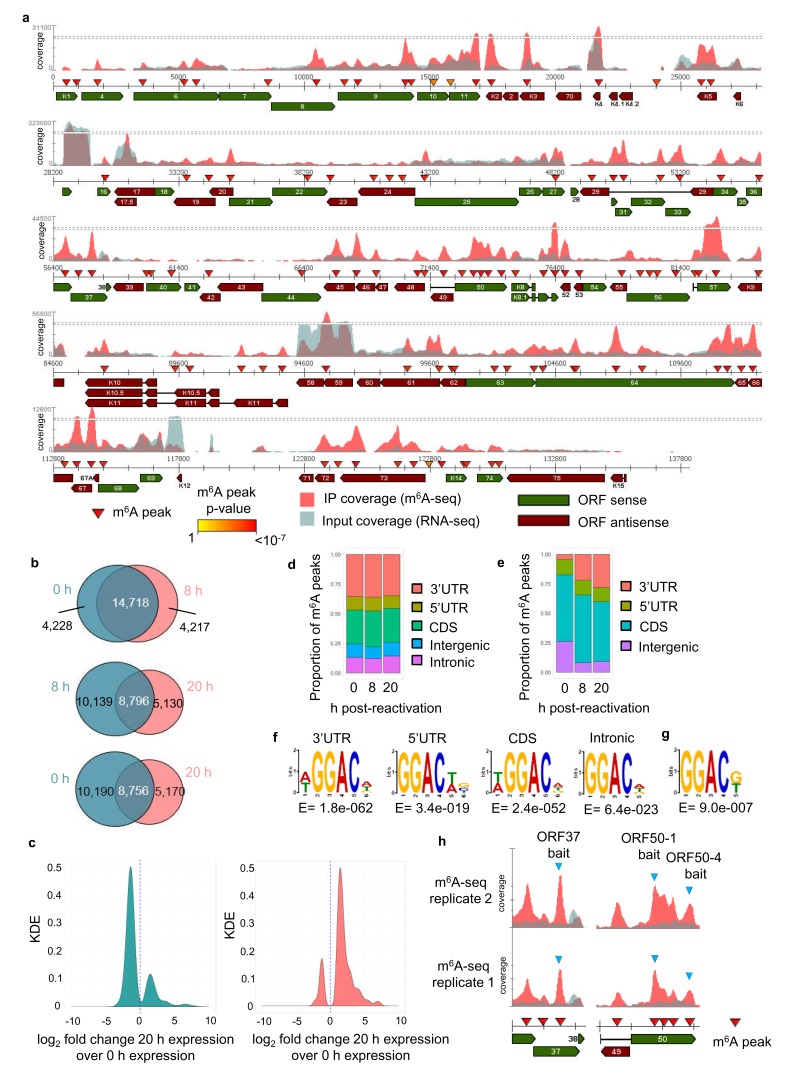
The KSHV transcriptome is extensively m6A-modified.(a) KSHV epitranscriptome map in TREx BCBL1-Rta cells at 20 hr post-lytic reactivation. m6A-IP reads and input reads are shown. m6A peaks identified by m6AViewer software with associated p-values are indicated. (b) Number of cellular m6A peaks consistently called by m6AViewer software in two biological replicates throughout KSHV infection. (a,b) To define significantly enriched m6A peaks in both viral and cellular RNAs, a minimum fold change of m6A-IP reads over input reads of ≥ 1.5 and a FDR < 5% was required in both biological replicates. Peaks positions were considered overlapping between replicates if the calls were within 100 nucleotides between corresponding positions. (c) Kernel density estimate (KDE) on the RNAs coding for the 10,190 m6A peaks present in latent but not 20 hr reactivated cells (left graph) and on the RNAs coding for the 5,170 m6A peaks present at 20 hr reactivation but not in latent cells (right graph). (d) Distribution of m6A peaks in five topological regions of cellular RNAs during latent and lytic KSHV replication. UTR, untranslated region. CDS, coding region. (e) Distribution of m6A peaks in four topological regions of viral RNAs during latent and lytic KSHV replication. UTR, untranslated region. CDS, coding region. (f) Most significantly enriched DRm6ACH consensus identified in m6A peaks present in four topological regions of cellular transcripts. MEME software was used for motif analysis. (g) Most significantly enriched DRm6ACH motif found in viral transcripts. MEME software was used for motif analysis. (h) RNA affinity baits were centred on the closest GGACU motif to the second m6A peak of open reading frame (ORF37) and the first and fourth m6A peaks of the second exon of ORF50 transcript (blue triangles). m6A-IP reads and input reads for ORF37 and ORF50 transcript from two biological replicates at 20 hr post-viral reactivation are shown.